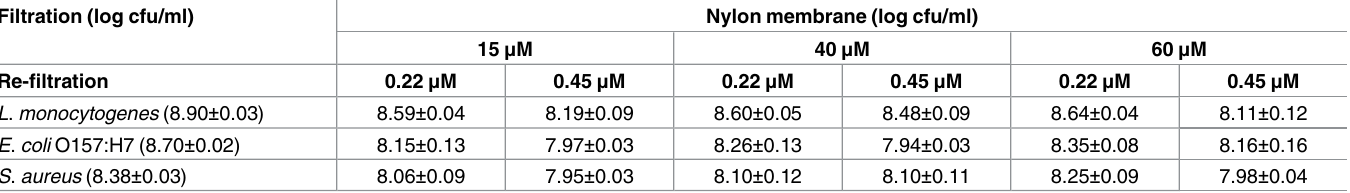
Table 4. Number of bacterial colonies for Listeria monocytogenes , Escherichia coli O157:H7,and Staphylococcus aureus inoculated on fresh-cut cantaloupe based on nylon membrane. Filtration (log cfu/ml) Nylon membrane (log